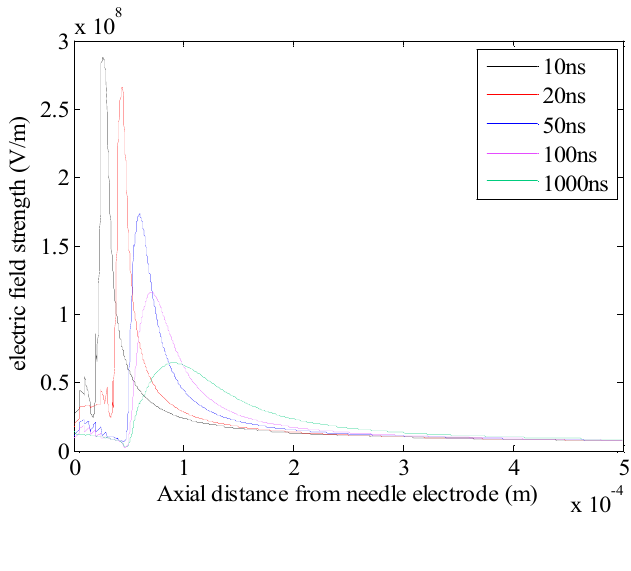
Figure 15. Electric field distribution along the needle-sphere axis as a response to 1.2 PDIV with 5 mm needle-sphere electrode